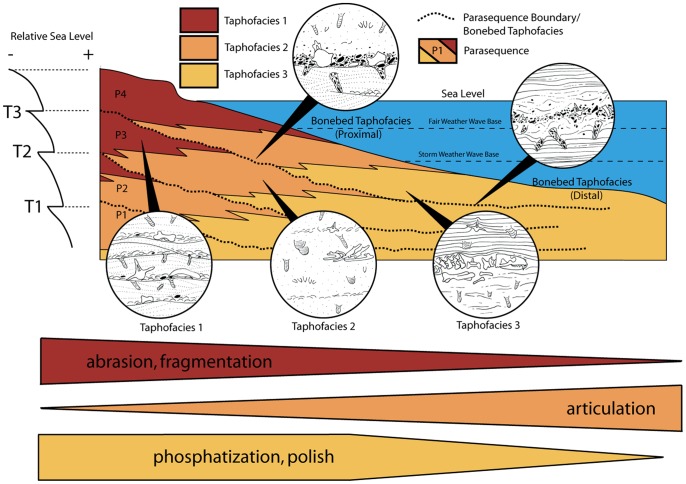
Cross-sectional taphofacies model of the Purisima Formation.Cross section of shelf is divided into taphofacies, and dashed lines representing bonebeds/parasequence boundaries; sea level shown on the left. Insets show diagrammatic representations of each taphofacies, including proximal and distal examples of the bonebed taphofacies. Relative impact of taphonomic attributes are shown at bottom.